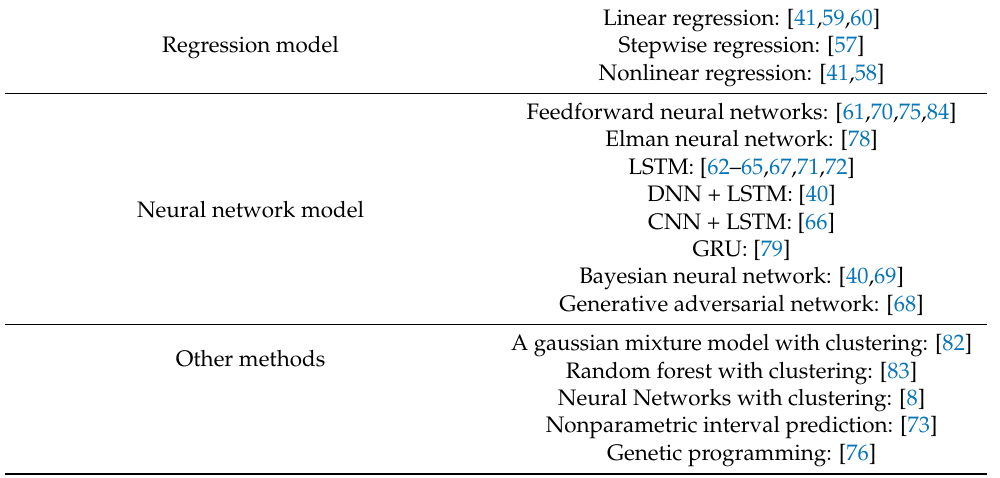
Table 2. Overview of machine learning model